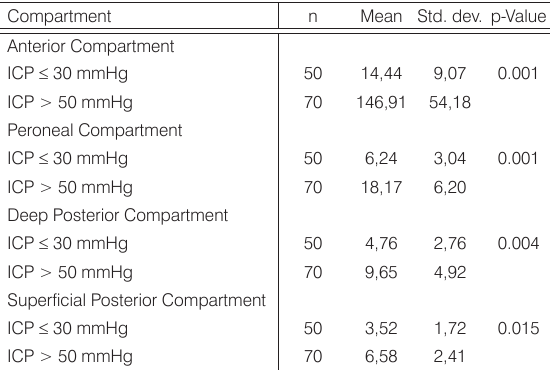
Table 2. t-Test in case of anterior LCS Compartment